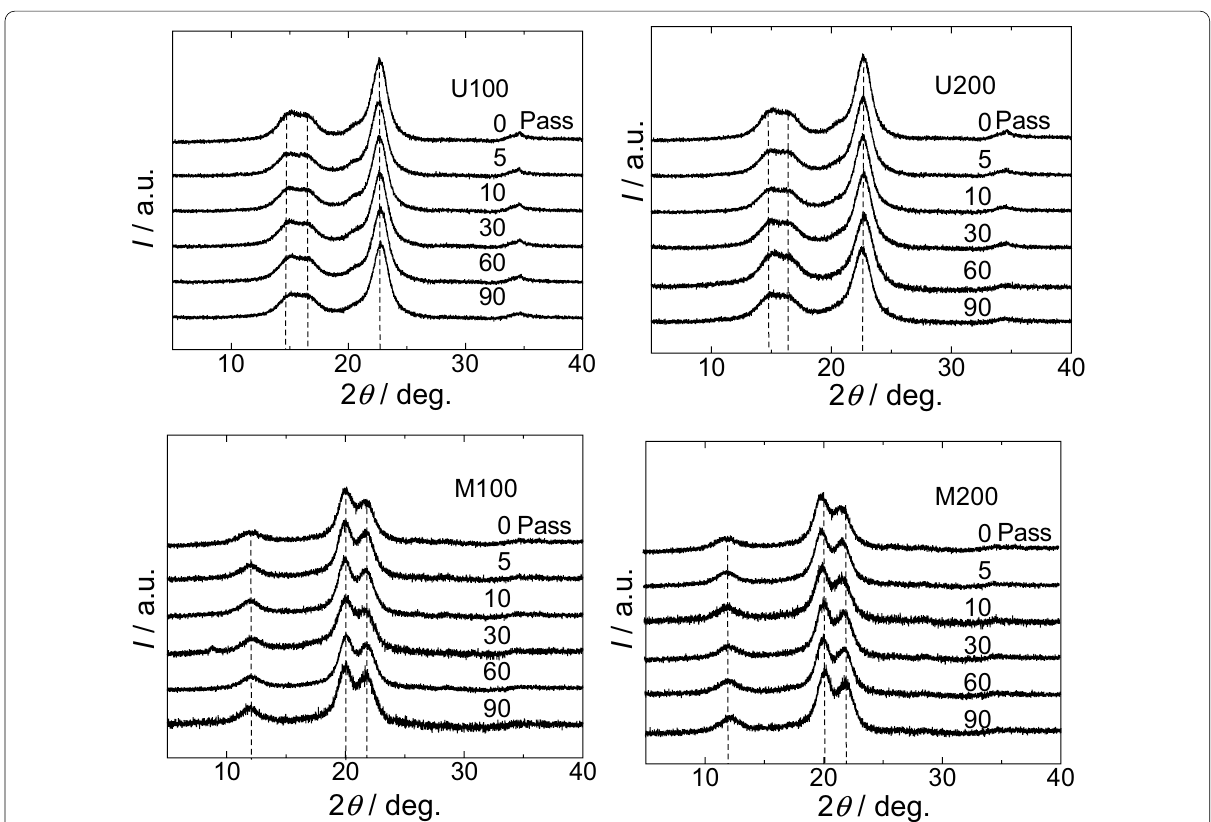
Fig. 3 WAXD profiles of ACC–CNFs from untreated (U) and mercerized (M)